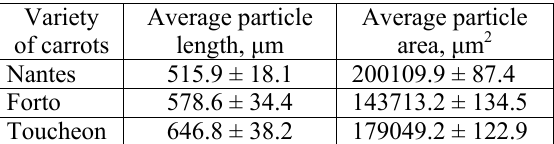
Table 6. Characteristics of the structure of carrot pulp